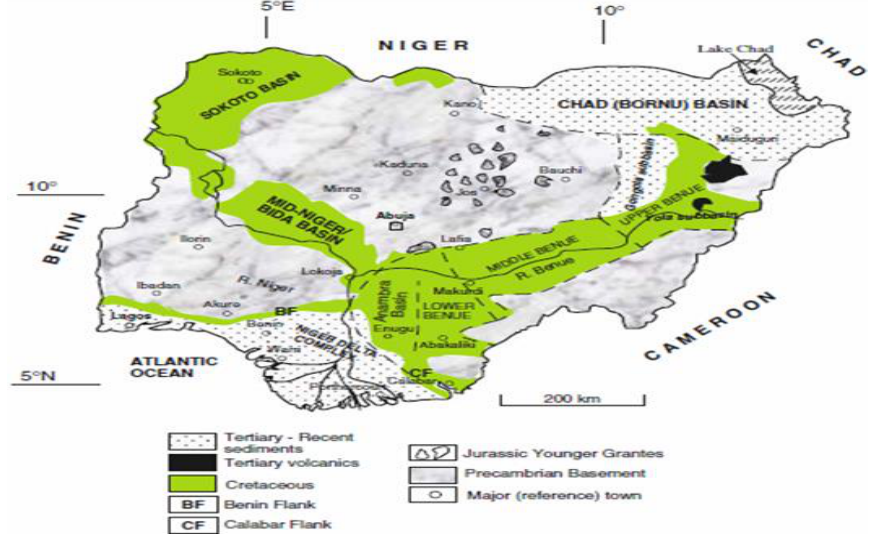
Figure 1: Geological Map of Nigeria (Obaje, 2009)